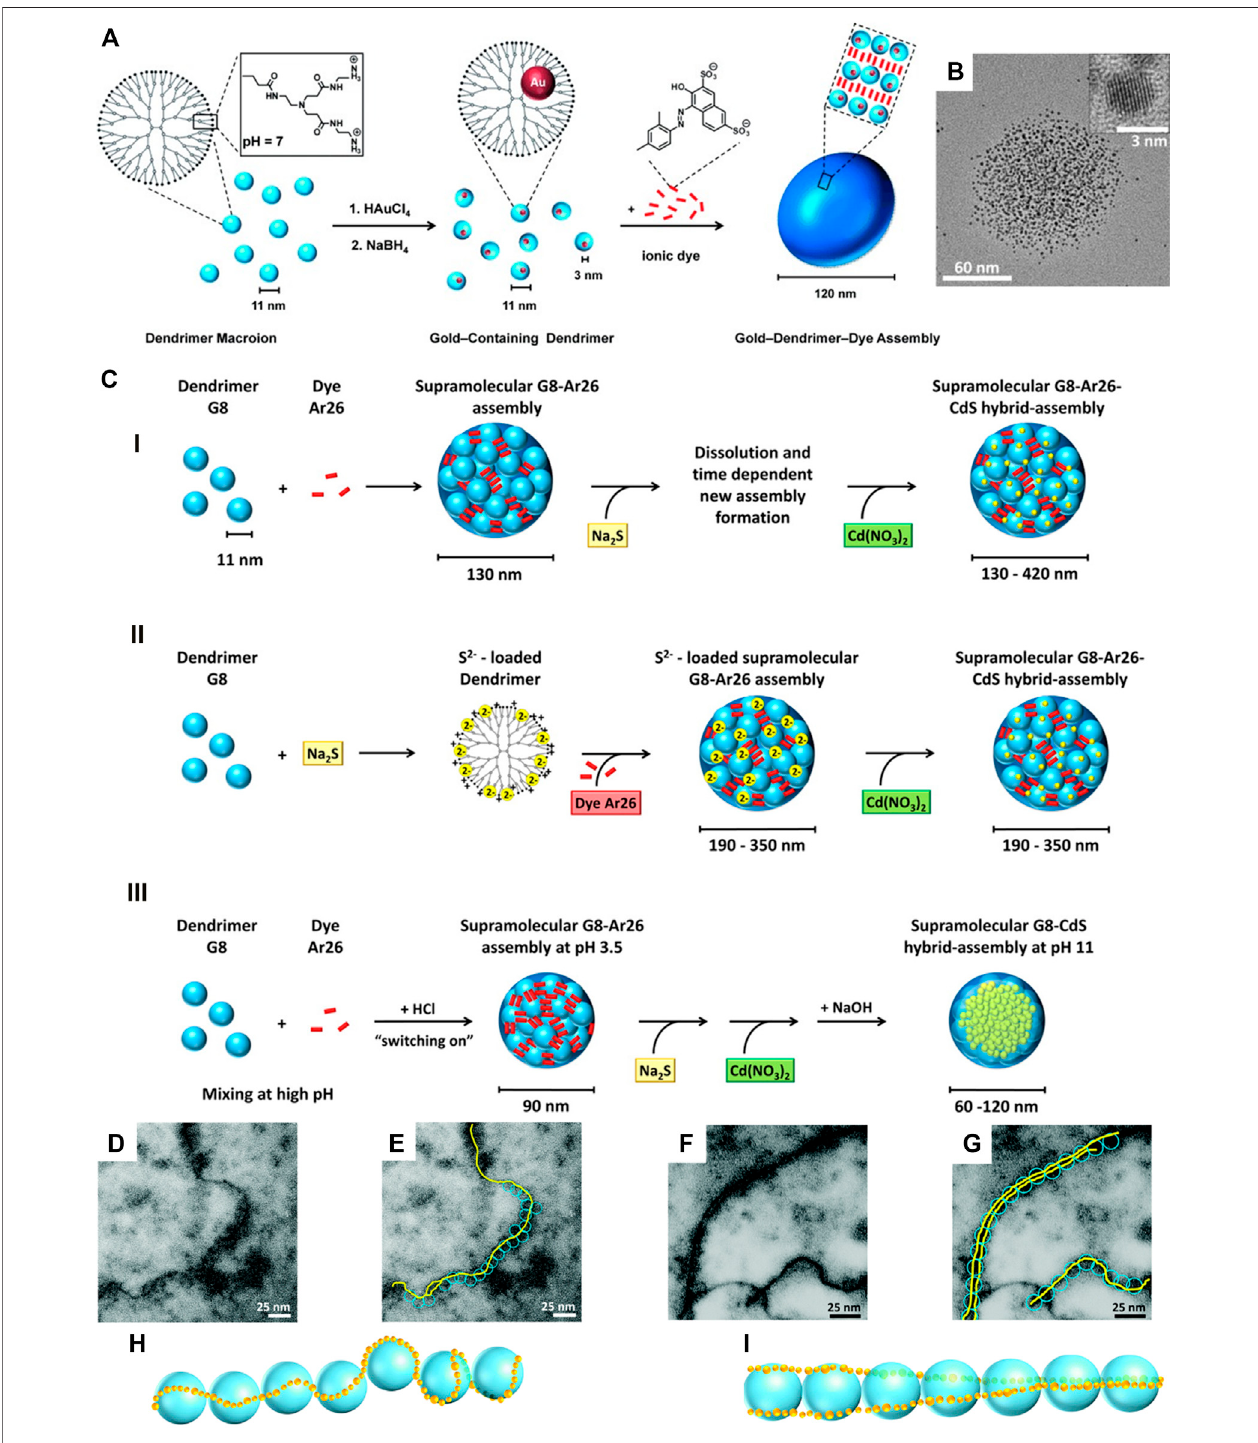
FIGURE 15 | CdS and Au nanoparticles in supramolecular dendrimer − dye assemblies: (A) Electrostatic nanotemlating-electrostatic self-assembly approach; (B) TEM of a 100 nm god-dendrimer-dye assembly containing 3 nm gold particles prepared according to (A) ; (C) overview of the electrostatic nanotemplating routes for CdSindendrimer – dyeassemblies; (D – I) CdS fi berswithdendrimerG9: (D,E) TEMofsingle- fi bers; (F,G) TEMofdouble- fi bers, (H,I) proposedorientationofCdS(yellow) and dendrimer (blue) (Düring et al., 2013; Düring et al., 2015; Düring and Gröhn, 2016). Reprinted with permission. Copyright © 2013 WILEY-VCH Verlag GmbH and Co. KGaA, Weinheim and © The Royal Society of Chemistry 2016 and © 2015 American Chemical Society.